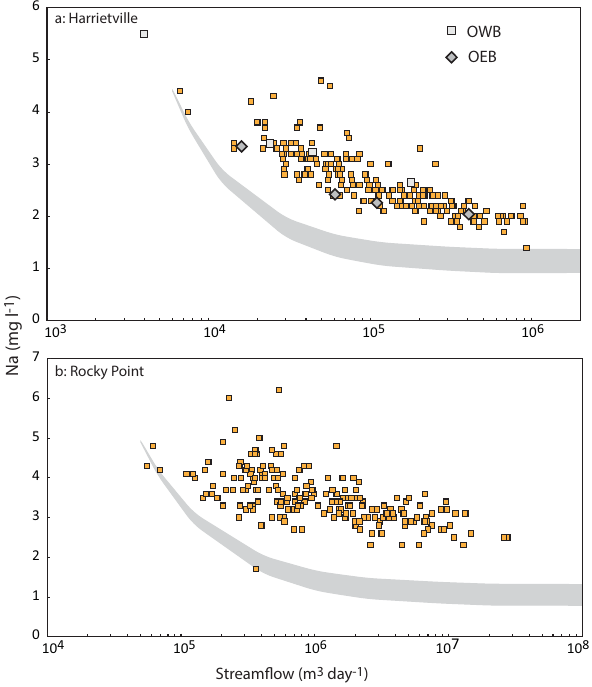
Figure 8. Na concentrations vs. streamflow for Harrietville (a) and Rocky Point (b) , data from the Department of Environment and Pri- mary Industries (2015). (a) also shows Na vs streamflow for the Ovens East Branch (OEB) and Ovens West Branch (OWB) tribu- taries which join just upstream of the Harrietville gauge (Fig. 1). Shaded fields depict mixing between baseflow, which is assumed to have a Na concentration of the lowest streamflow at each site, and rainfall with a Na concentration of 0.9 to 1.3mgL − 1 calculated us- ing Eq. (4). The mixing model underestimates the Na concentration recorded at higher flows at both